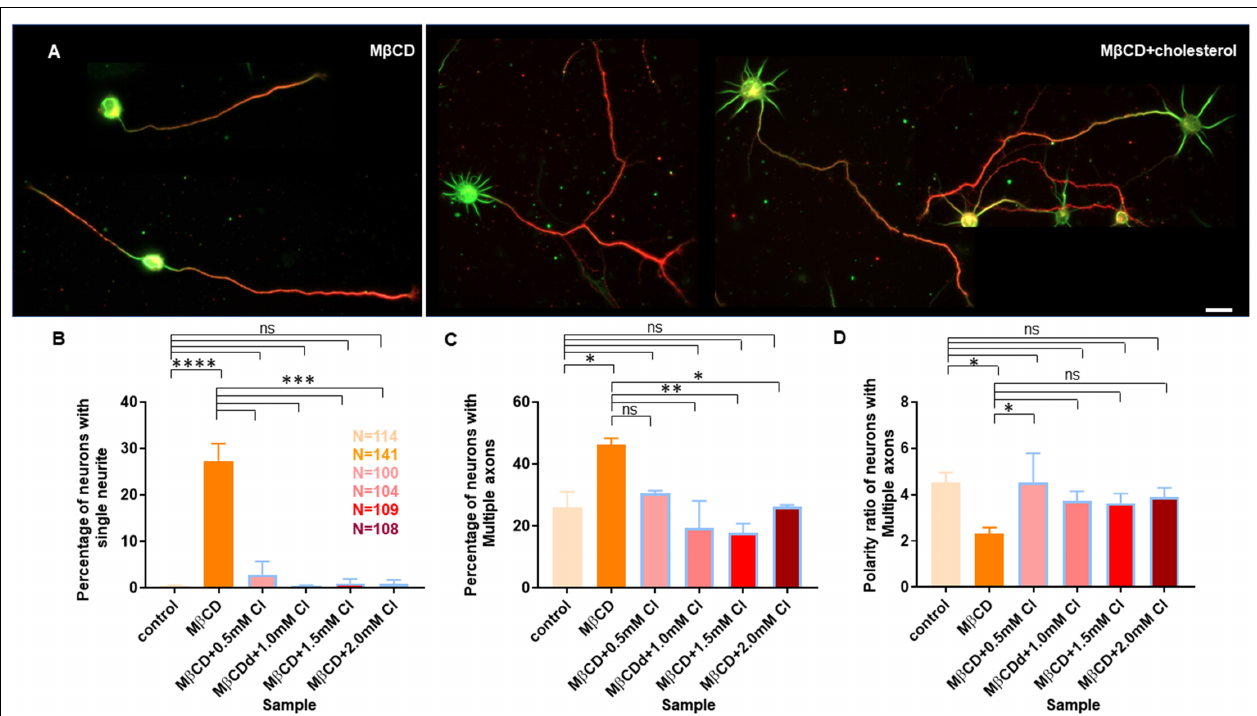
FIGURE 7 | Transient cholesterol replenishment rescues neurite arborization and polarity defects caused by cholesterol sequestering. (A) Depicts the morphological transition of neurons upon cholesterol sequestering and transient replenishment with exogenous cholesterol. (B) Percentage of cells with single neurites upon transient application of 5 mM M β CD followed by varying amounts of exogenous cholesterol for 10 min. (C) Percentage of cells displaying supernumerary axons upon transient application of 5 mM M β CD followed by varying amounts of exogenous cholesterol for 10 min. (D) Polarity ratio of neurons exhibiting supernumerary axons as calculated from (C) . Neuronal arborization and polarity defects in cholesterol sequestered neurons were significantly rescued upon transient cholesterol replenishment. In the population of neurons displaying supernumerary axons, the polarity ratio was increased to control values in cholesterol supplemented cells, showing their reversal to an asymmetric growth pattern. N denotes the number of cells from three independent cultures. One-way Anova was performed to test the significance of the difference between the means. ∗∗∗∗ p < 0.0001, ∗∗∗ p < 0.001, ∗∗ p < 0.01, ∗ p < 0.05. Scale bar indicates 20 µ m. ns,